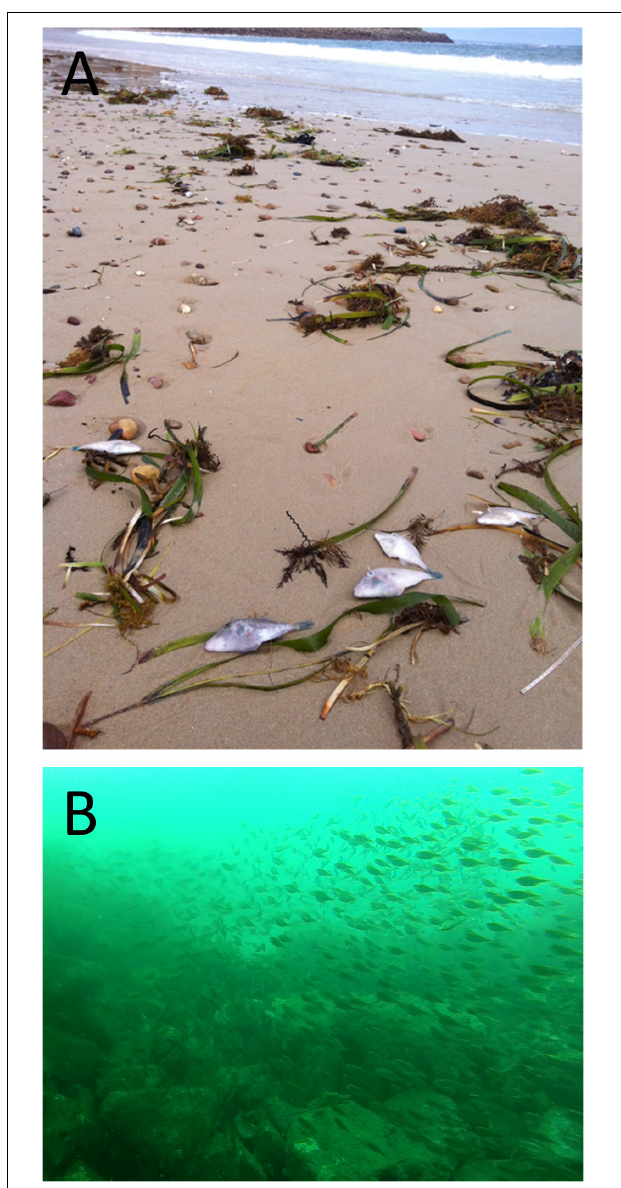
FIGURE 10 | Dead Degens Leatherjackets ( Thamnaconus degeni ) washed up at Port Noarlunga (A) and screenshots of underwater video footage taken on 4 April 2013 in the coastal waters of the Adelaide metropolitan coastline of large schools of apparently healthy Degens Leatherjackets (B)